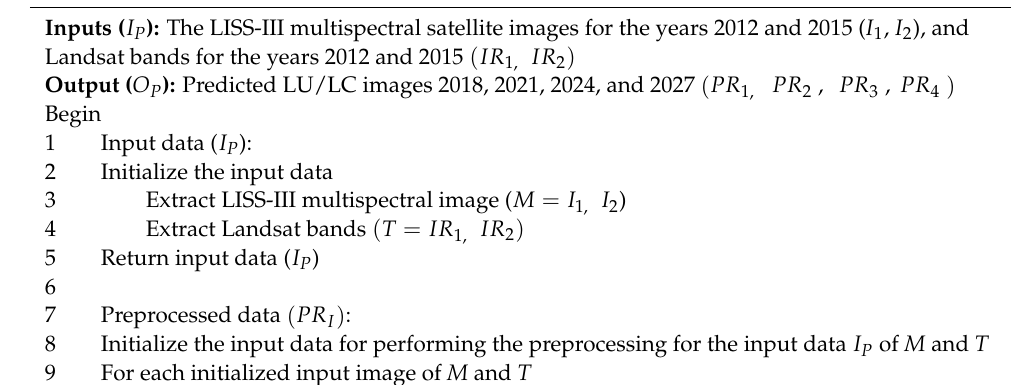
Algorithm 1 : To Construct the Vision Transformer–Based Bi-LSTM Prediction Algorithm 1: To Construct the Vision Transformer–Based Bi-LSTM Prediction Model. Inputs ( 𝑰 𝑷 ): The LISS-III multispectral satellite images for the years 2012 and 2015 ( 𝐼 (cid:2869), 𝐼 (cid:2870) ), and Landsat bands for the years 2012 and 2015 (𝐼𝑅 (cid:2869), 𝐼𝑅 (cid:2870) )